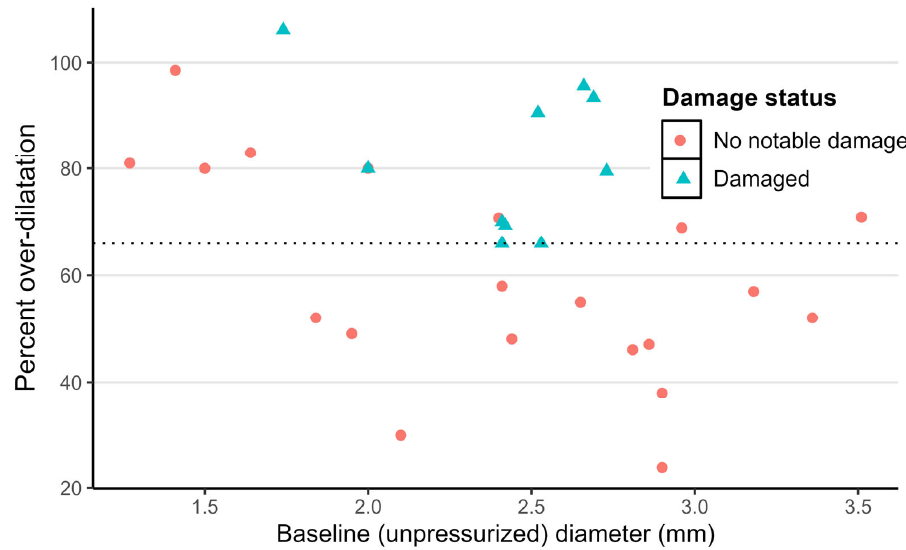
Figure 6. Distribution of Over-Dilatation by Baseline Diameter of Human Veins. Distribution of percent over-dilatation of human vein segments dilated by the VRS-AVF device. The X axis depicts the baseline lumen diameter of the veins prior to treatment. The Y axis shows the percent over-dilatation over the baseline. Each vein is represented by one data point. Red dots illustrate veins without any histological damage, and blue triangles represent veins with noticeable histological damage. A bench top perfusion system was used to test the distensibility of the veins after VRS-AVF treatment with or without the step of light activation (Figure 7A). The pulsatile pressure and outer diameter were stable as shown by three consecutive cycles in Figure 7B. The mean fl ow rate was 240 mL/min. The balloon distension pressure values were similar (8.8 ± 2.2 vs. 8.2 ± 2.7 atm for the veins with or without light activation, respec- tively), and the levels of over-dilatation were also similar (58 ± 12 vs. 55 ± 7% for the veins with or without light activation, respectively). The minimum, maximum, and pulse per- fusion pressure values and the mean outer diameters during perfusion were similar (Table 1). The veins without light activation had a slightly larger percent outer diameter change during a pulsatile cycle and were slightly more distensible than the veins with light acti- vation (Table 1), but the di ff erence was not statistically signi fi cant ( p = 0.25 and p = 0.23 for percent diameter change and distensibility, respectively).